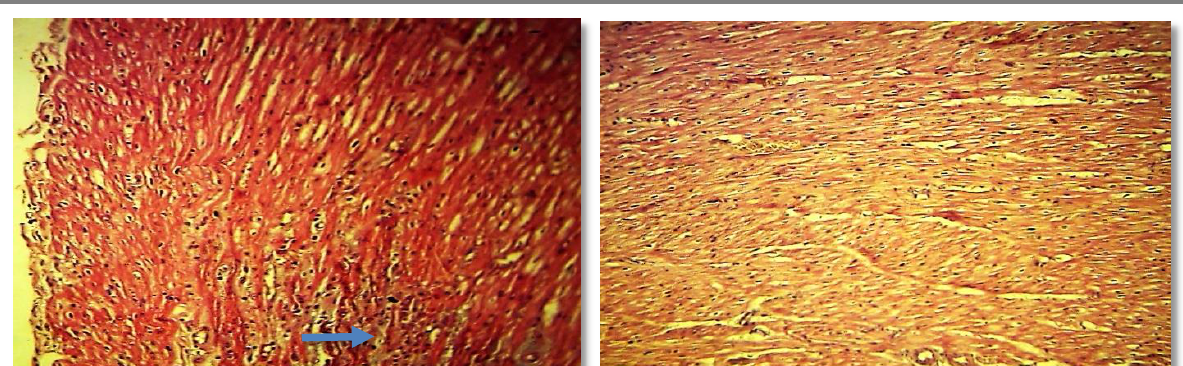
Figure,7: Section in the cardiac muscle of rabbit after 42 days of treatment with methionine over load and pometon (group T2). Note: moderate edema between muscle fiber (H &E stain 40X).